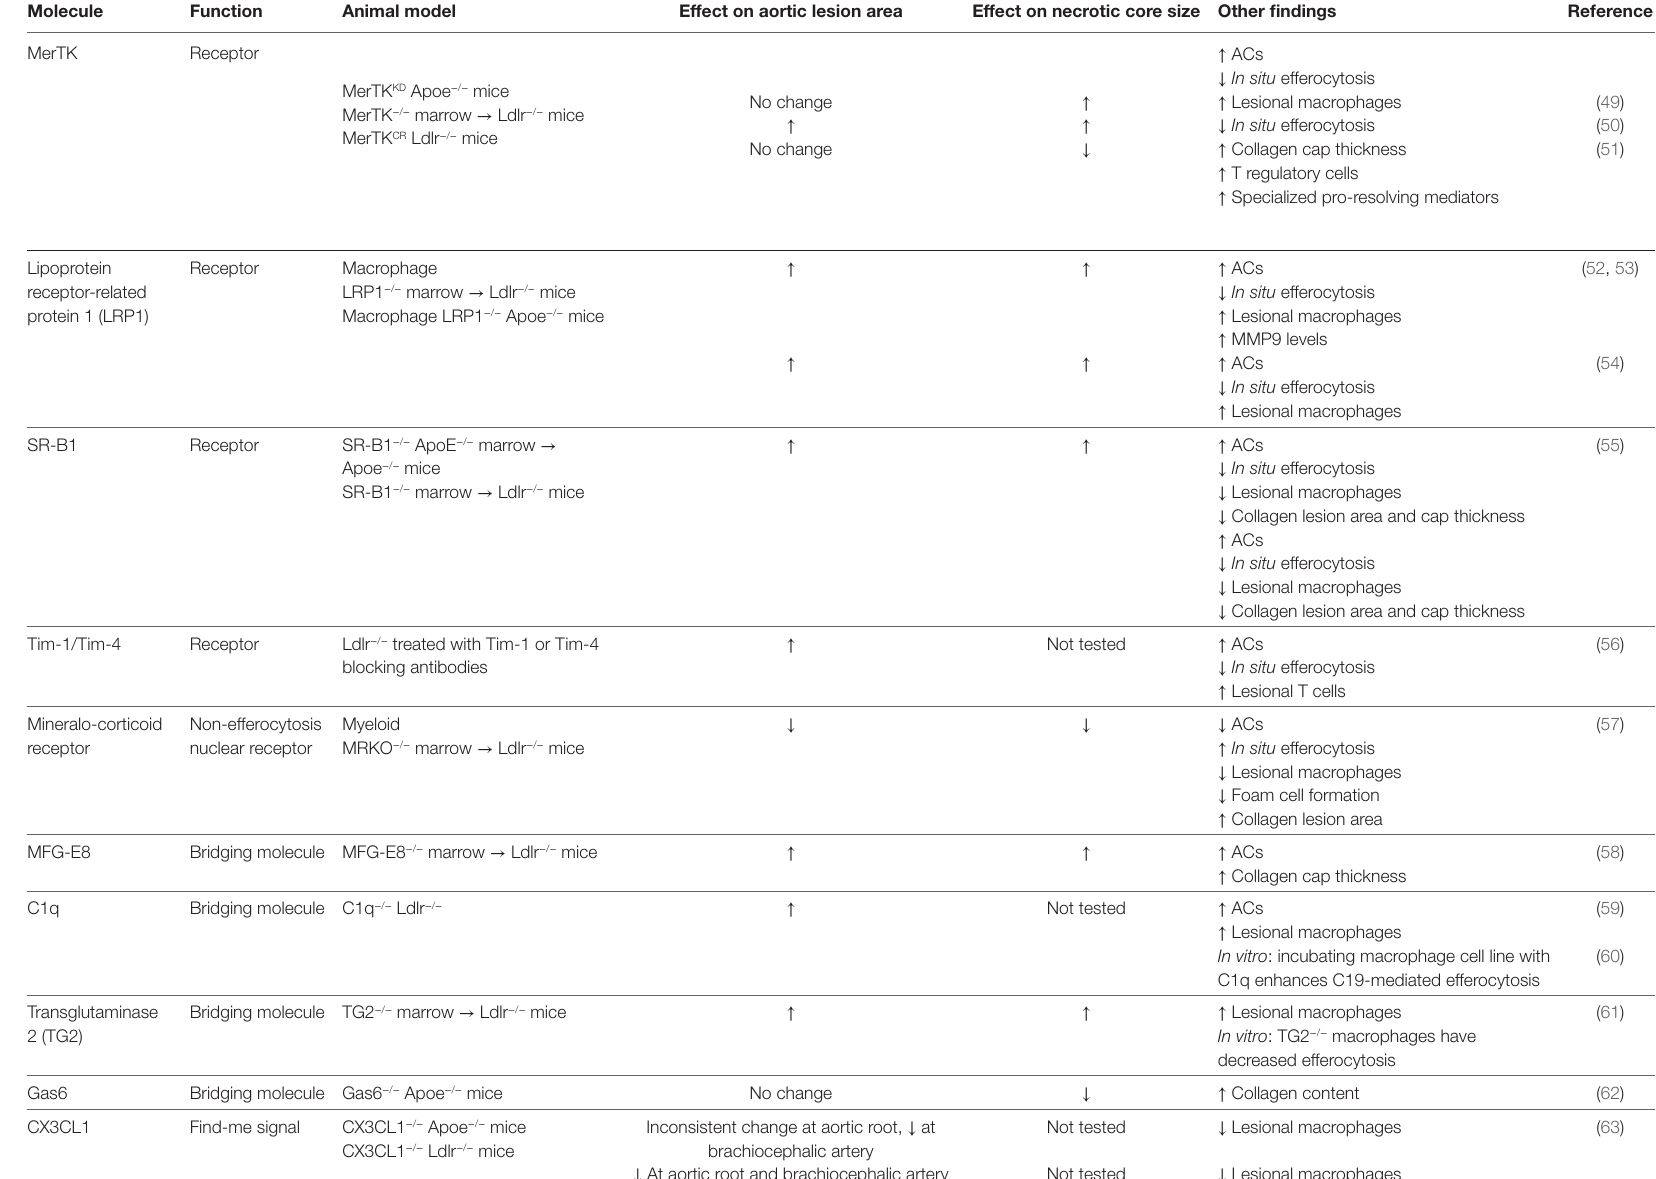
TABLe 1 | Efferocytosis pathway molecules shown to have a causative role in